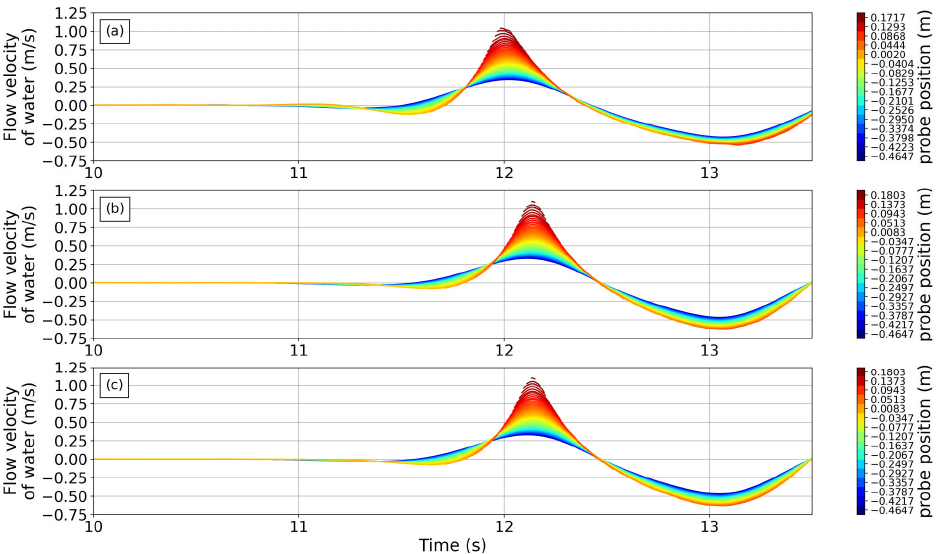
Figure 13. Time histories of flow velocities at probe points in the second scenario at the upstream cylinder ( a ), at the downstream starboard cylinder ( b ), and at the downstream portside cylinder ( c ) for the tripod configuration consisting of medium-diameter cylinders. The color bar indicates the vertical position of the probe points.